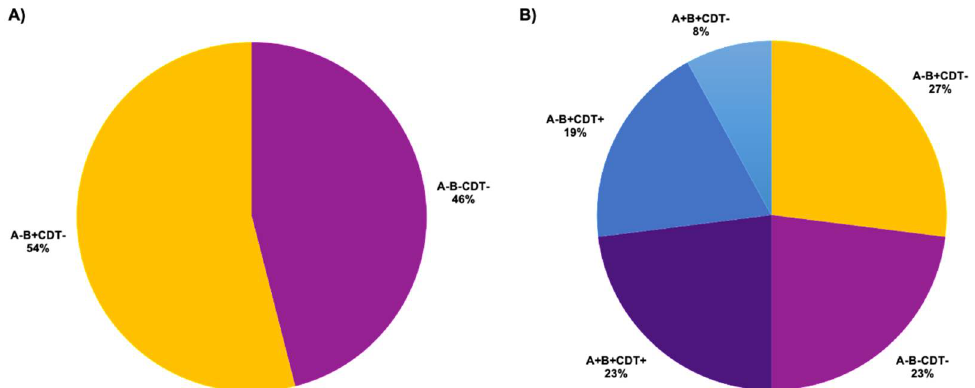
Figure 1. Toxin gene analysis of C. difficile isolates. The distribution of toxin profiles in C. difficile isolates from ( A ) THA group, which contained C. difficile isolates collected from 2006 to 2009 (n = 50) and ( B ) THB group, which contained C. difficile isolates collected from 2010 to 2012 (n = 26). Toxin profiles were characterized based on the presence of toxin genes and the deletion of tcdA 3′-end. A, B, and CDT represent tcdA , tcdB , and cdtAB .